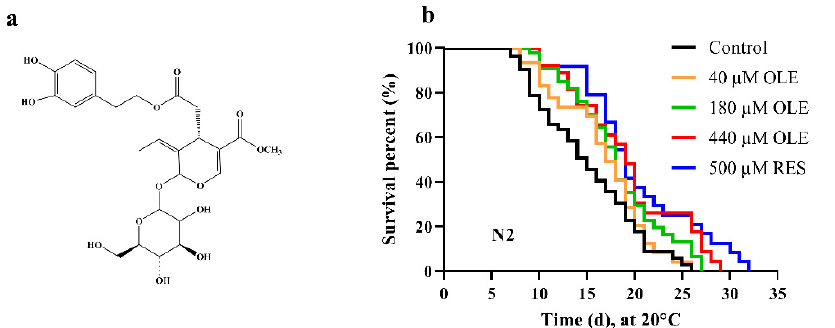
Figure 1. ( a ) Chemical structure of OLE. ( b ) Effect of OLE on the lifespan of wild-type worms. Caenorhabditis elegans is a simple structure and transparent roundworm. This free- living nematode is a powerful genetic model animal mostly known for aging research due to its relatively short lifespan. It has been used by many to evaluate the ameliorative effects associated with longevity and stress of natural products. Studies have uncov- ered several signaling pathways interfering with stress response and the aging process, such as insulin/insulin-like growth factor signaling (IIS), which was conservative from worms to mammals. In C. elegans , IIS originates with insulin-like peptides binding the DAF-2 receptor to activate the phosphoinositide 3-kinase (AGE-1/PI3K). Subsequently, activated AGE-1 triggers the downstream phosphorylation cascade reactions starting from 3-phosphoinositide-dependent kinase 1 (PDK-1) to Akt/protein kinase B family members (AKT-1 and AKT-2), which in turn leads to the phosphorylation of DAF-16/FoxO transcrip- tion factor and inhibits its translocalization activity into the nucleus. DAF-16 is a crucial component in IIS that directly regulates longevity and various stress response in worms